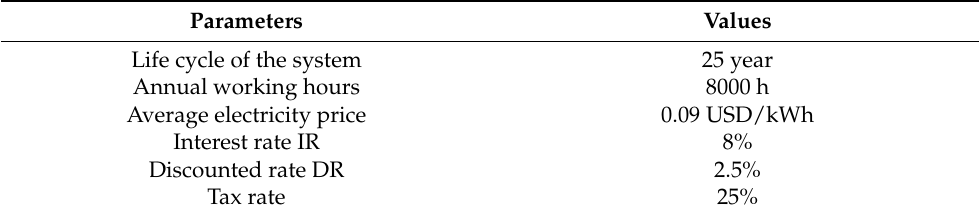
Table 5. Assumptions for the economic